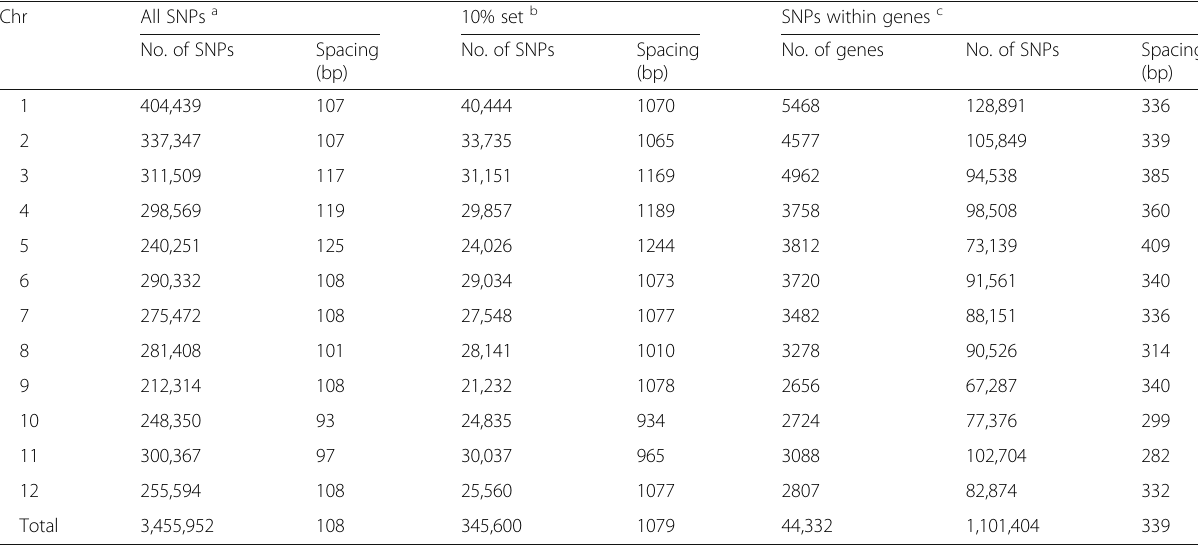
Table 2 Distribution of high quality SNP markers in the rice